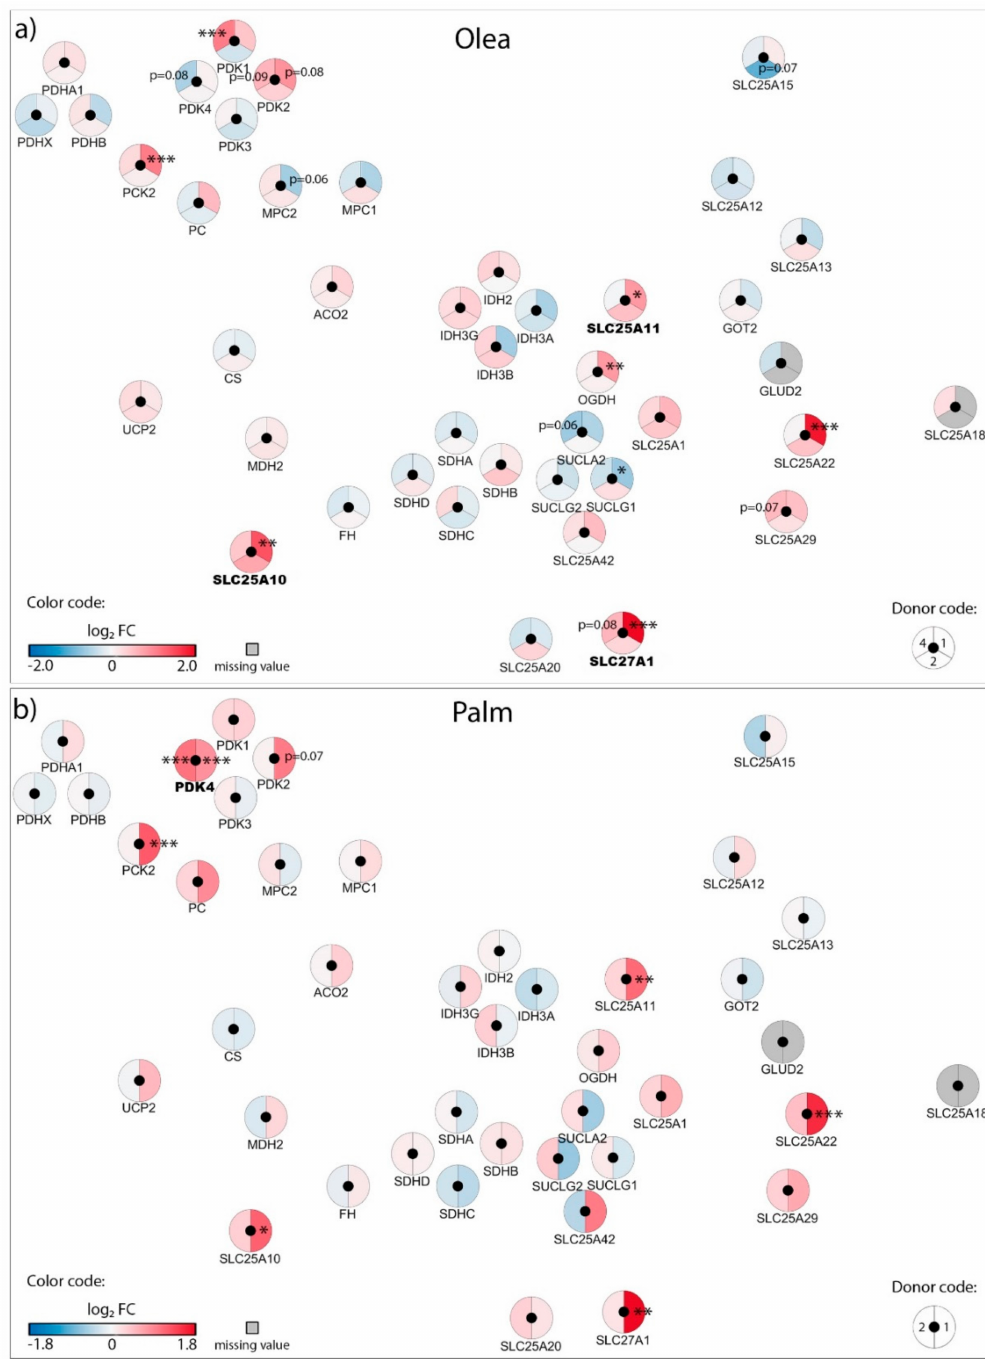
Figure 2. E ff ects of oleate (Olea) and palmitate (Palm) on the transcriptional regulation of mitochondrial solute carriers and associated genes: pyruvate metabolism, TCA cycle enzymes, amino acid metabolism and fatty acid transport. Human islets were exposed to 0.4 mM ( a ) Olea or ( b ) Palm at standard glucose concentration (G5.5) for 3 days before RNA-Seq analysis. E ff ects of lipotoxic culture conditions on transcriptlevelsarecomparedtostandardG5.5mediumandshownasupregulated(red), downregulated (blue), or unchanged (white). Missing values are represented in grey. Each disk is split into individual changes for the di ff erent islet donors. Color code reflects the transcriptional changes in log 2 fold changes (log 2 FC) for that particular gene in individual donors. Clinical data from individual donors are shown in Supplementary Table S1, while quantitative transcriptional data are shown in Supplementary Table S2. * adjusted p < 0.05, ** adjusted p < 0.01, *** adjusted p < 0.001 between control 5.5 mM glucose and the specific culture